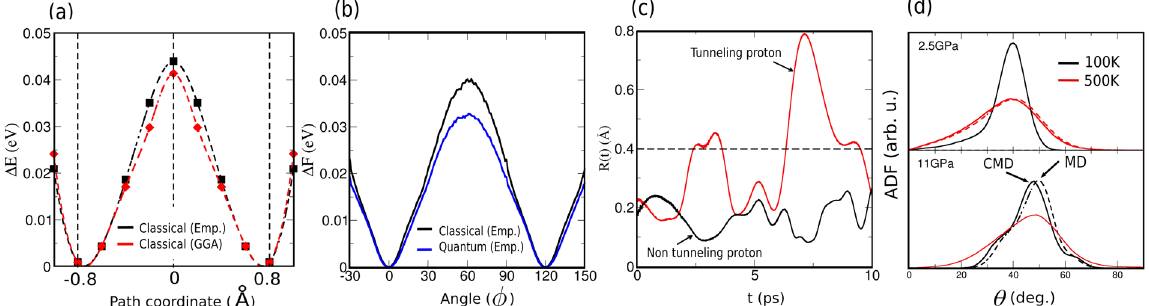
Figure 3. ( a ) Potential energy profile calculated with empirical force fields (black line) and BLYP functionals (red line) at 11 Gpa, computed along a straight line between two bassins. ( b ) Classical and quantum free energy profiles versus the angle φ (see text). ( c ) Proton correlation function. The dotted line indicates the approximate midway-distance between two minima for quantum nuclei. ( d ) θ angular distribution function of all hydroxyl  c groups tilting from the